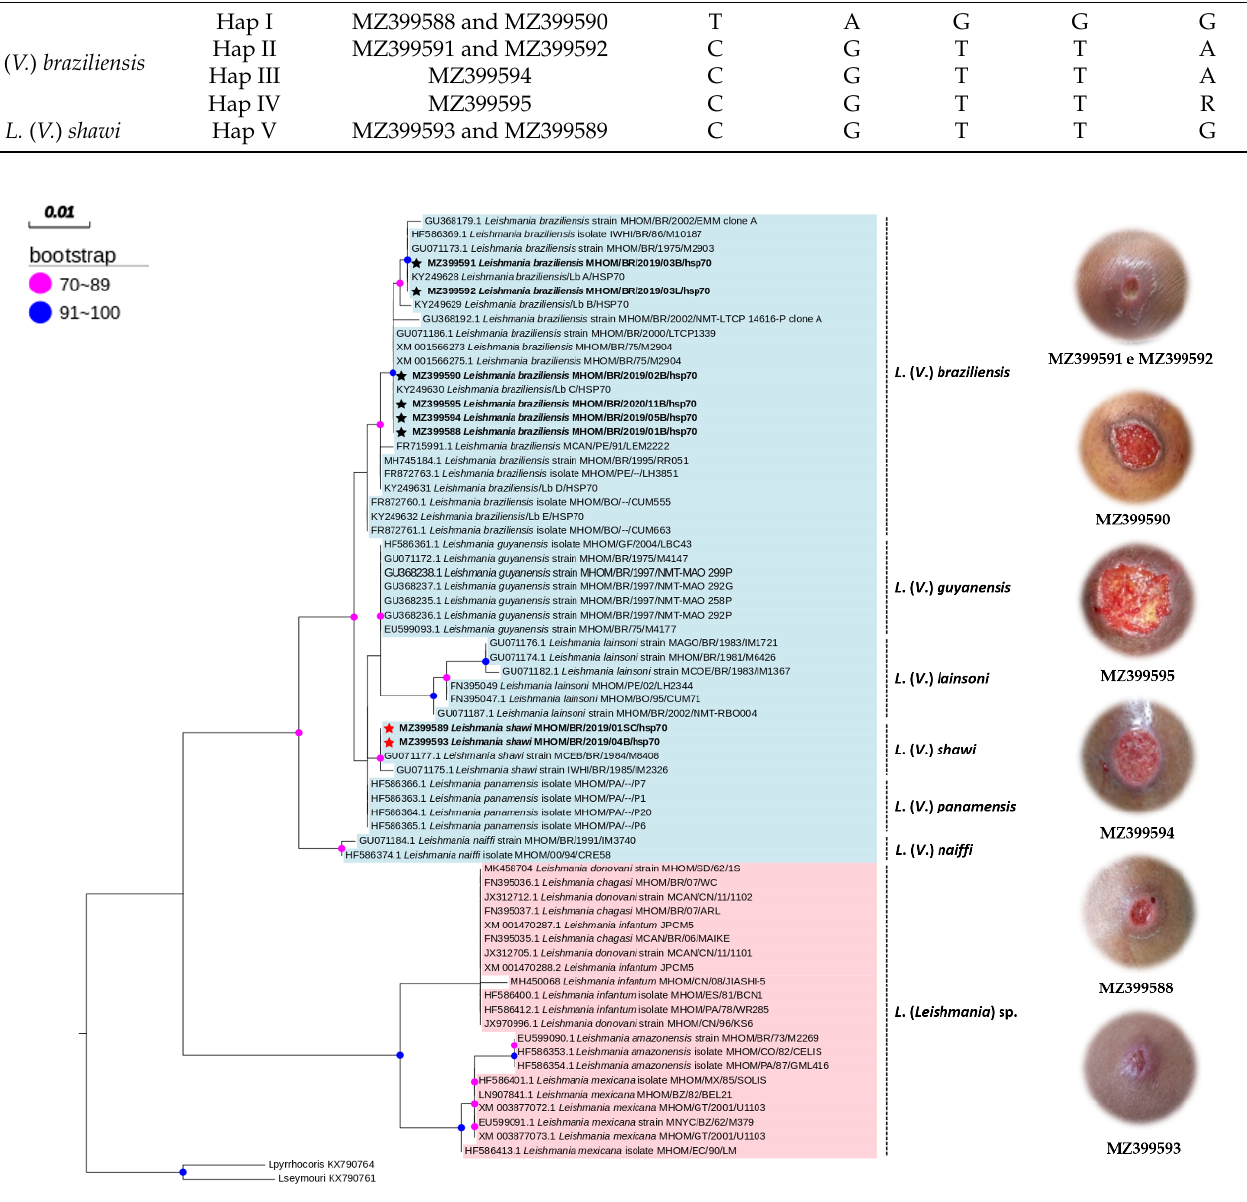
Figure 2. Phylogenetic tree of the genus Leishmania estimated using maximum likelihood of hsp70- (234 bp). Sequences of Leptomonas pyrrhocons and Leptomonas seymourii were used as an external group. The tree involved 67 nucleotide sequences, 7 of which were obtained in this study. The identified sequences of L. (V.) shawi are identified with a star ( (cid:70) ) and L. (V.) braziliensis also marked by a ( (cid:70) ), and were related to the clinical characteristics of the lesions observed during the study.